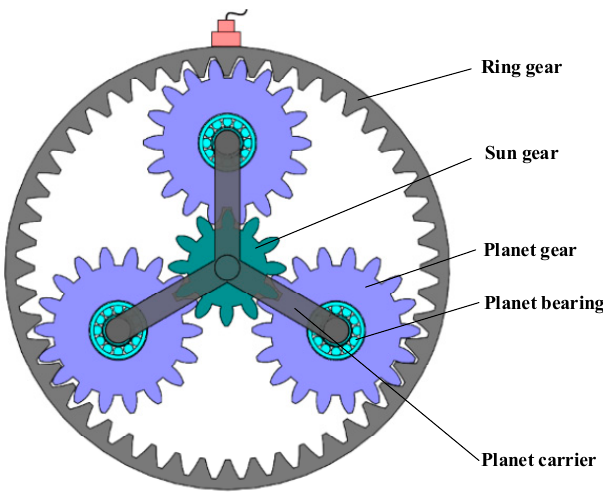
Figure 5. Structure of the planetary stage.